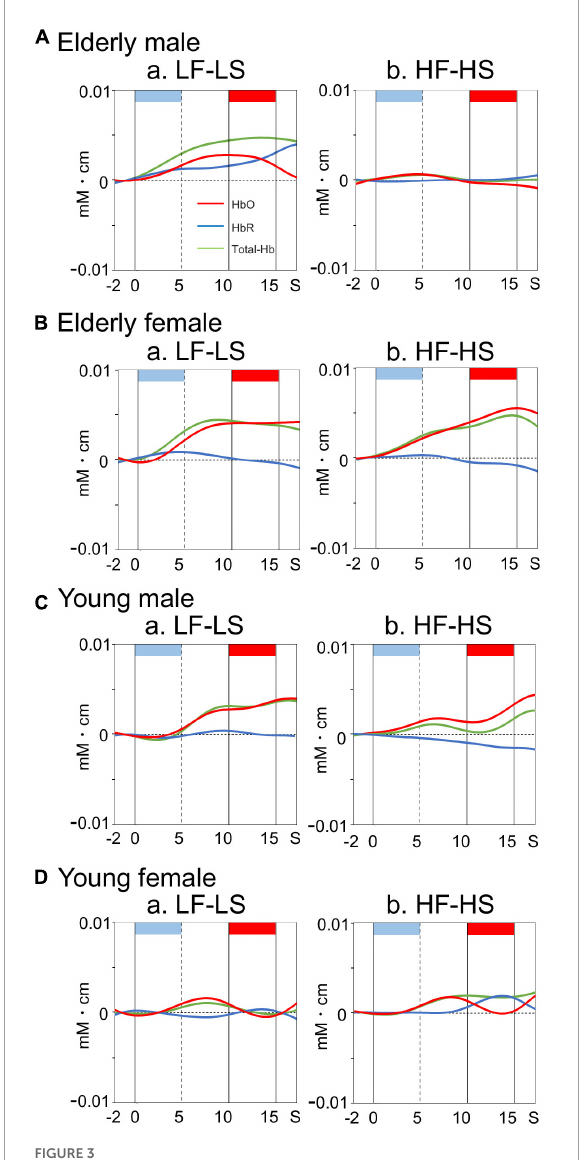
FIGURE3 Examples of time courses of cerebral hemodynamic activity in the right dl-PFC during the differential conditioning task in elderly male (A) , elderly female (B) , young male (C) , and young female (D) groups. Hemodynamic signals are recorded from Ch 41 [MNI coordinates: (22, 57, 37) mm] in an elderly male (A) , Ch 41 [MNI coordinates: (30, 55, 34) mm] in an elderly female (B) , Ch 41 [MNI coordinates: (29, 55, 34) mm] in a young male (C) , and Ch 41 [MNI coordinates: (27, 60, 27)] in a young female (D) participant. Light blue and red rectangles at the top of each graph indicate sound presentation and electrical shock periods, respectively. Red, blue, and green lines indicate HbO, HbR, and Total-Hb, respectively. Other descriptions are as for Figure 2 .